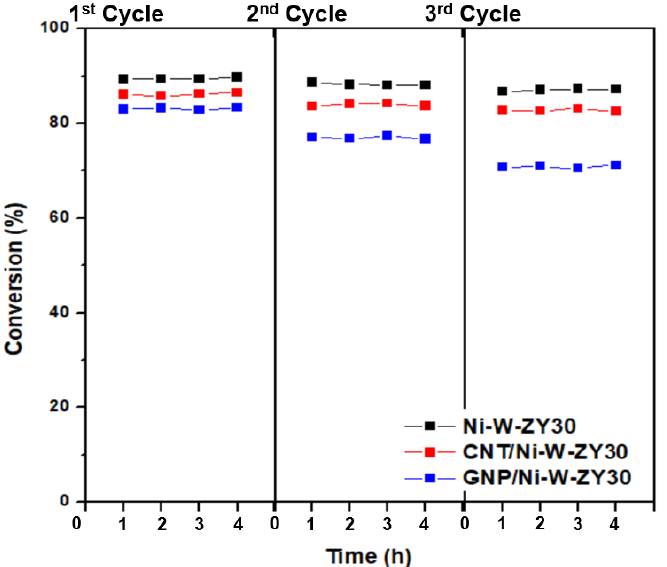
Figure 9. Conversion (%) over Ni-W-ZY30, CNT/Ni-W-ZY30, and GNP/Ni-W-ZY30 catalysts, after regenerating them in three repeated cycles.